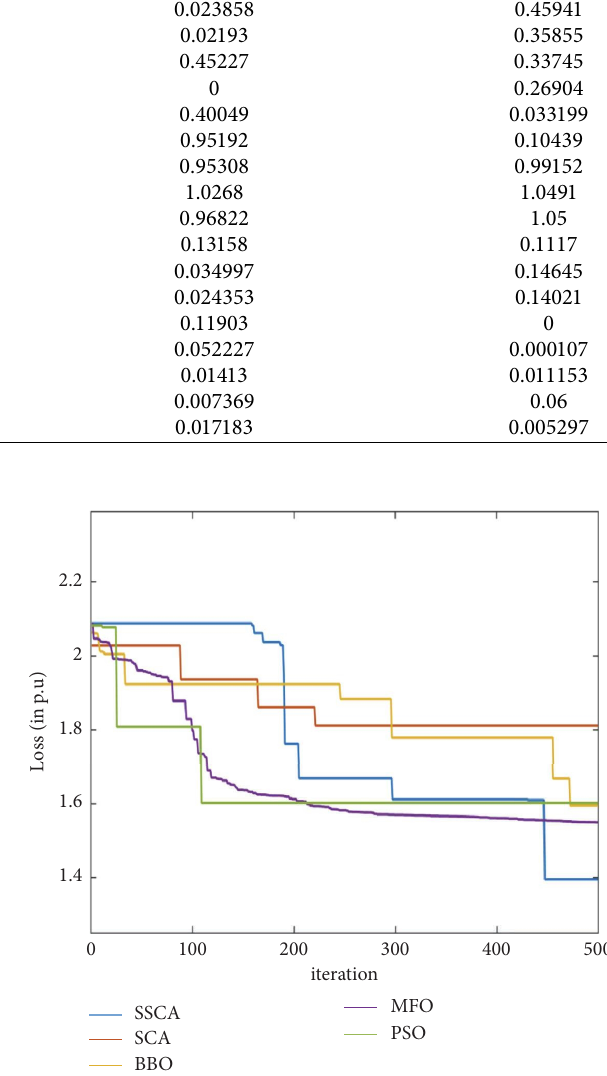
Figure 10: Loss variation in the IEEE-118 bus system at 100% loading.